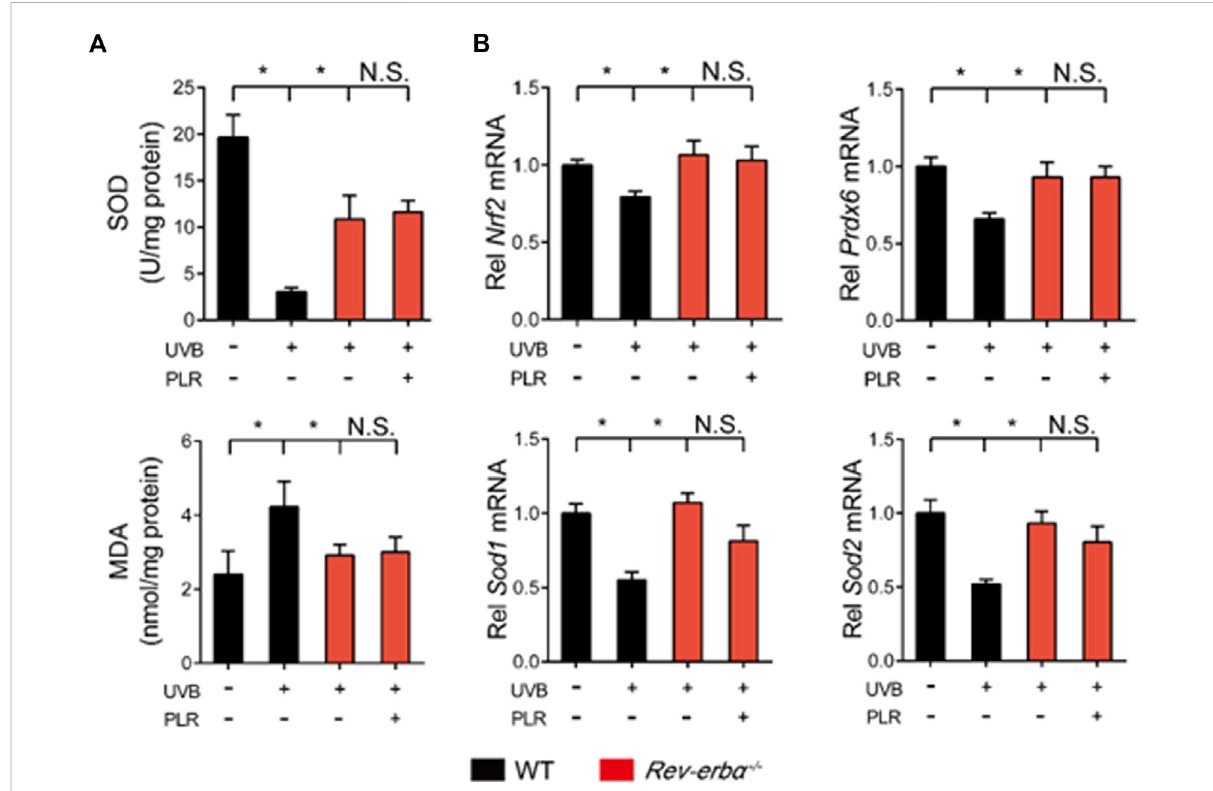
FIGURE 9 REV-ERB α is required for the protective effect of PLR on skin aging. (A) SOD activity and MDA level in the skin. (B) Expression levels of Nrf2 , Prdx6 , Sod1 , and Sod2 mRNA in the skin. 400 mg/kg PLR was used to treat the skin of mice. Data are presented as mean ± SD ( n = 4). * p < 0.05. WT, wide type; N.S, not signi fi